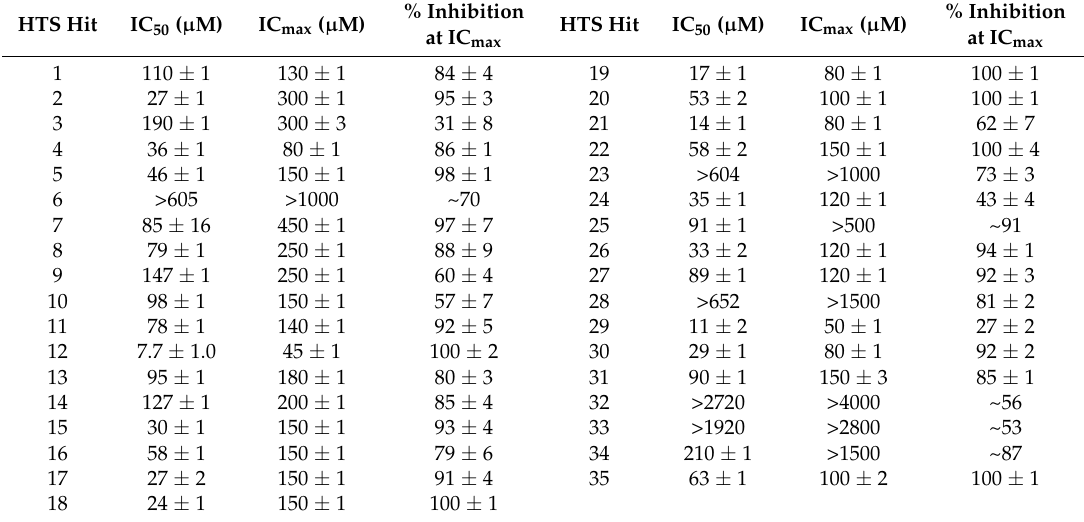
Table 1. Effect of HTS hits on the NADPH-dependent DCPIP diaphorase activity of Xcc FPR. Kinetic measurements were carried out at 25 ◦ C, in 50 mM Tris/HCl, 2% DMSO, pH 8.0, using 20 nM Xcc FPR, with saturating DCPIP (95 µ M) and NADPH (50 µ M), and varying the hits concentration in the 0–800 µ M range ( n > 2, means ± SD). IC 50 and IC max stand for the concentration of the compound causing 50% enzyme inhibition and maximal inhibition, respectively. All shown Xcc FPR inhibition percentages at IC max are statistically significant (***, p <